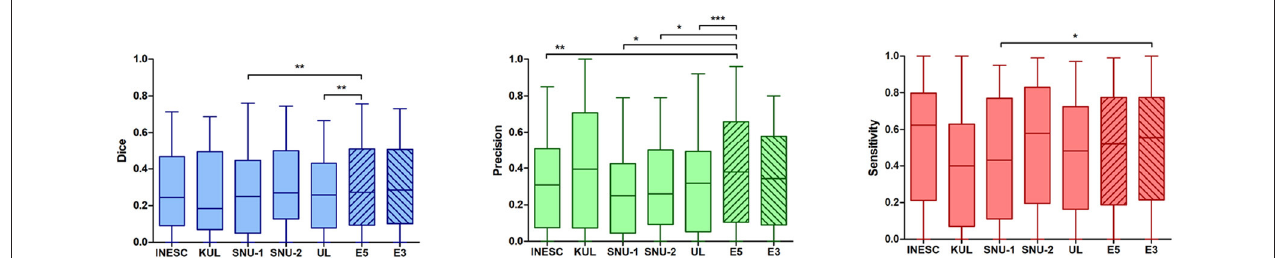
FIGURE 7 | Statistical comparison of lesion prediction performance of single models vs. ensembles. Left : An ensemble of five models (E5) could improve the Dice score in comparison to the two weaker models (SNU-1 p < 0.01, UL p < 0.05). This effect was, however, not observed when building an ensemble with three models (E3). Middle : The ensemble E5 significantly gained precision in contrast to most of the single models (SNU-1 p < 0.01, SNU-2 p < 0.05, UL p < 0.001, INESC p < 0.01). KUL’s precision was higher or similar to that of the ensembles, showing no significant difference. Right : The ensemble E3 was found to be more sensitive to predict lesion than SNU-1’s model. Overall the models show a fair ability to detect lesions. * p < 0.05, ** p < 0.01, and *** p < 0.001.